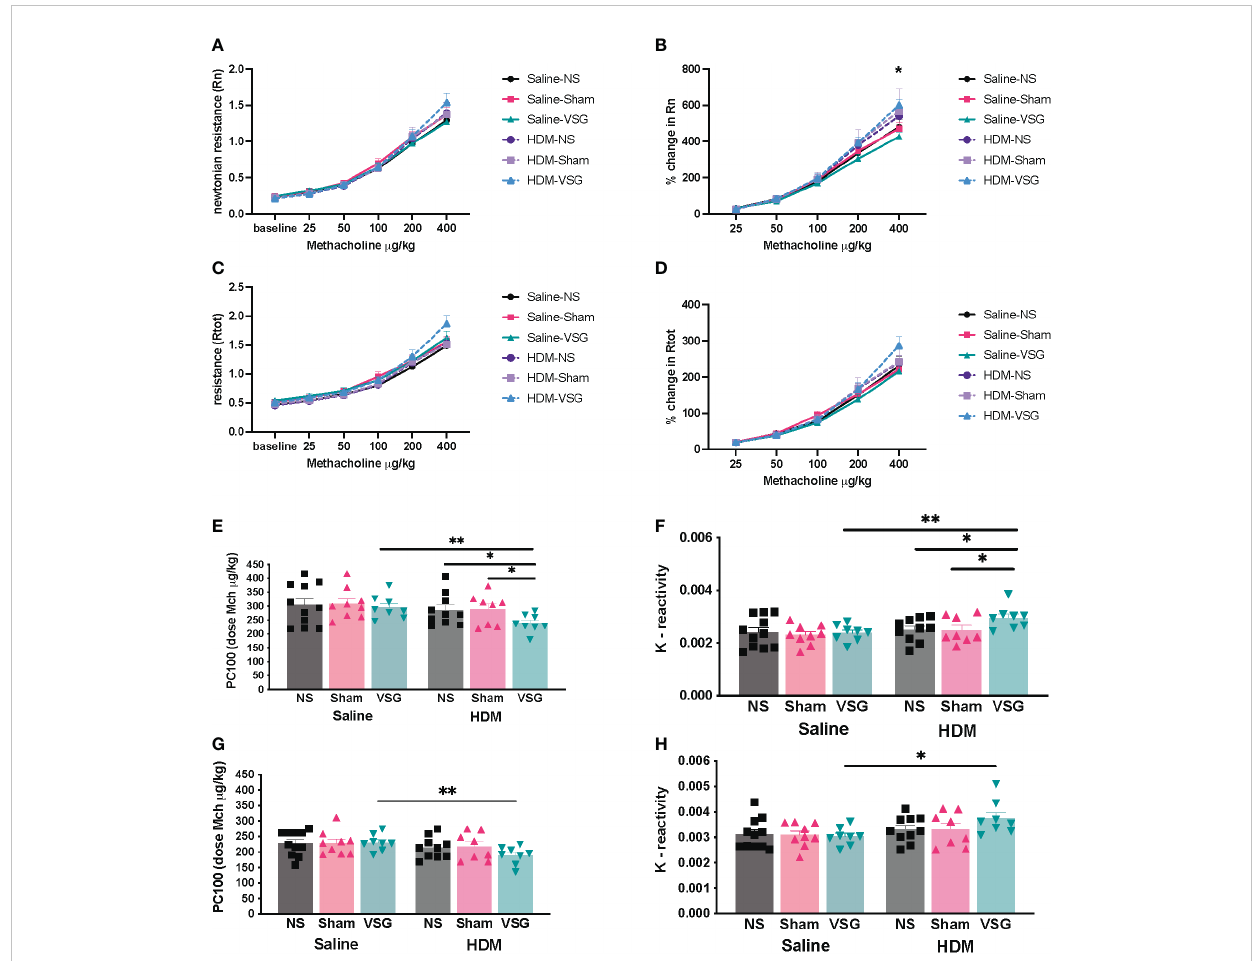
FIGURE 6 Effects of HDM challenge and VSG on lung mechanics. (A) Newtonian resistance [Rn], (B) percent change in Newtonian resistance (p<0.05 for HDM/ VSG vs Saline/VSG), (C) total respiratory resistance [Rtot], and (D) percent change in total respiratory resistance with intravenous methacholine challenge, n=8-11 mice per group. (E) PC100 for Rtot, n=8-10 mice per group. (F) Reactivity [K] for Rtot, n=8-10 mice per group. (G) PC100 for Rn, n=8-10 mice per group. (H) Reactivity [K] for Rn, n=7-10 mice per group. (A – D) were analyzed using repeated measures ANOVA and (E – H) were analyzed using one-tailed t-test with Welch ’ s correction factor. *p<0.05;